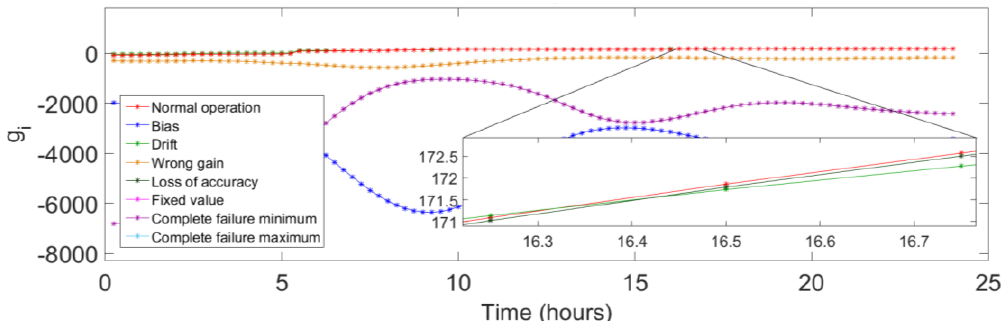
Figure 2. Normal operation diagnosis: graphs of the FDA discriminant functions gi(x) for each of the normal and seven fault classes, along the 24 h of the 140th day and the detailed representation revealing the class of the observations and the time moment of the firm normal operation identification.